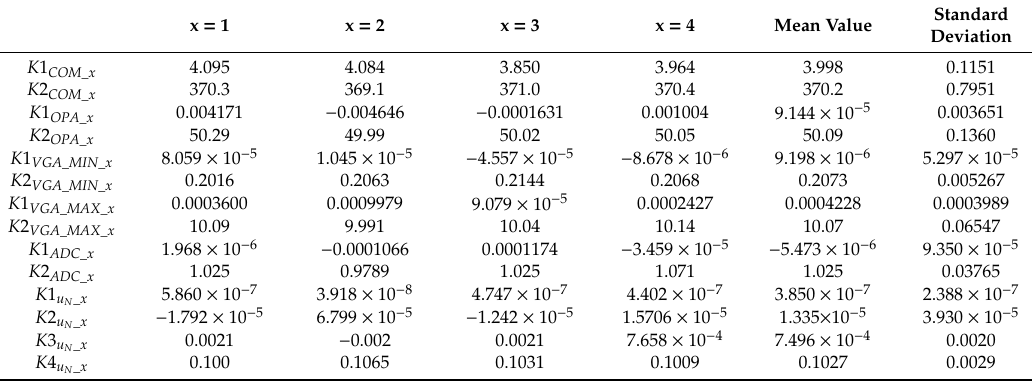
Table 1. The parameters of fitted curve for each node of four